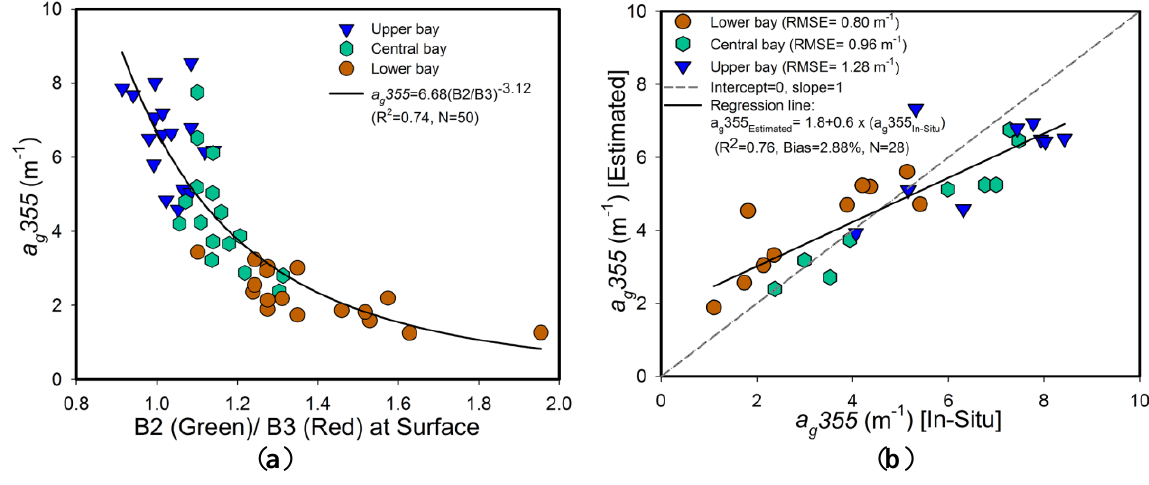
Figure 7. ( a ) Power law relationship between the CDOM absorption coefficient and the Landsat band ratio (Green/Red). The a g 355 band ratio algorithm: a g 355 = 6.68 × (B2/B3) −3.12 (R 2 = 0.74, N = 50). ( b ) Validation of a band ratio algorithm (R 2 = 0.76, N =